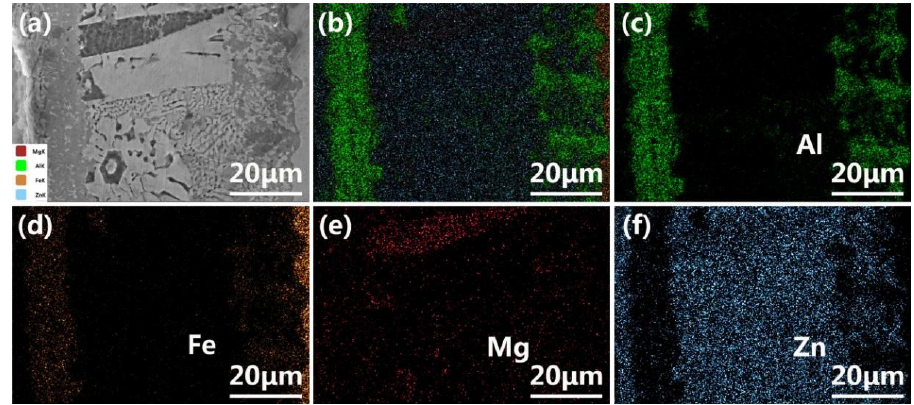
Figure 12. XRD pattern of the residual oxidized layer of coating of the unpolished steel plate.